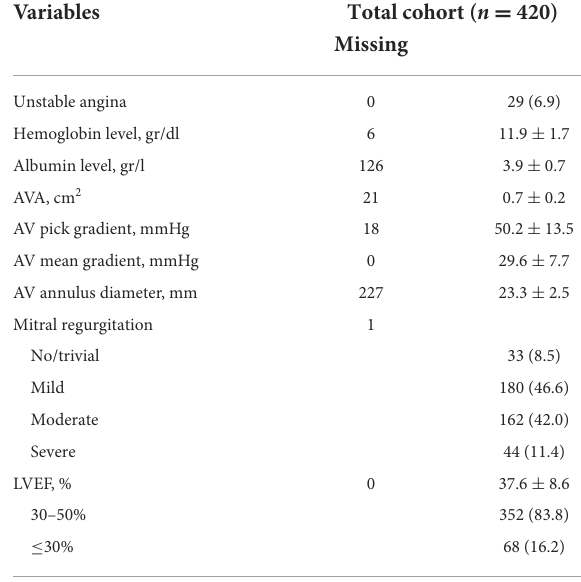
TABLE 1 Baseline characteristics of patients with LFLG AS included in OBSERVANT II